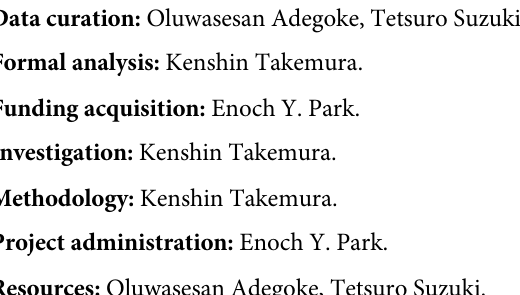
S2 Fig. DLS hydrodynamic curves (A–D) and Zeta potential (ZP) (A1–D1) for the thiol- capped AuNPs (red curves) and the Ab-AuNPs (green curves). The thiol capping agents are (A, A1) GSH, (B, B1) TGA, (C, C1) MPA and (D, D1) -cyst. Green and red curves indicate L for the thiol-capped AuNPs and the Ab-AuNPs, respectively. The thiol capping are (A1) GSH, (B1) TGA, (C1) MPA and (D1) L-cyst. S3 Fig. DLS hydrodynamic curves for the QDs before (red curve) and after (green curve) conjugation to the antibody. S4 Fig. Effect of Ab-QDs and Ab-AuNPs ratio in detection solution. ZIKV concentration was 10 RNA copies/mL. S5 Fig. ELISA showing the strong binding affinity of the NS1 antibody to the NS1 protein in Zika virus sample solution. S6 Fig. Fluorescence intensity changes for ZIKV using the immuno-QDs without LSPR- amplified signal from the plasmonic AuNPs. S7 Fig. Fluorescence enhancement spectrum of the Ab-QDs as it correlates to the detected ZIKV using the LSPR signal amplifier of A) Ab-GSH-AuNPs, B) Ab-TGA-AuNPs, C) Ab- MPA-AuNPs, and D) Ab- L-cyst-AuNPs. S8 Fig. DLS hydrodynamic curves for A) QD-Ab-ZIKV-Ab-MPA-AuNPs and B) QD-Ab- ZIKV-Ab-L-cyst-AuNPs. Peaks of A, B and C are 38.6, 106.8 and 212.0 nm, respectively. S9 Fig. Fluorescence enhancement spectrum of the Ab-QDs. Influenza virus A (H1N1) was detected using the LSPR signal amplifier of Ab-MPA-AuNP in DI water (A), in human serum (B). Calibration curve (C) for Ab-MPA AuNP in DI water ( � ) and in human serum (•).